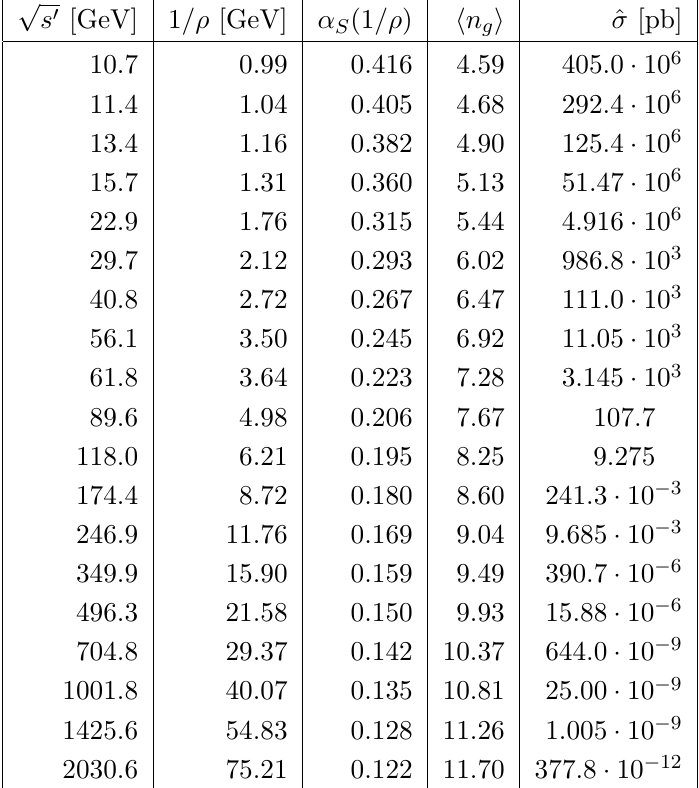
Table 1 . Data points for the inverse instanton radius, 1 =(cid:26) , a leading-order value of (cid:11) s , the expected number of gluons, h n g i and the partonic instanton cross-sections ^ (cid:27) ( s 0 ) of eqs. (2.52){(2.54) in the range of 10 GeV{2